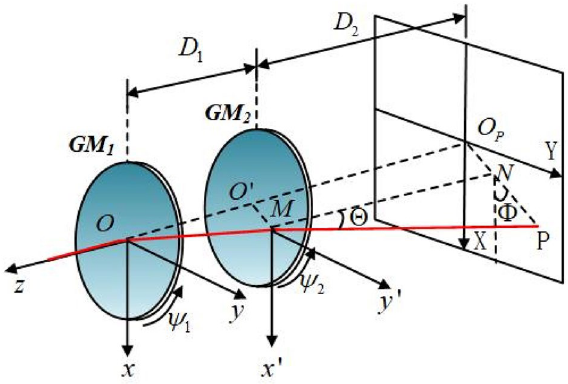
Figure 1. Schematic diagram of the proposed beam-steering double-metalens system.